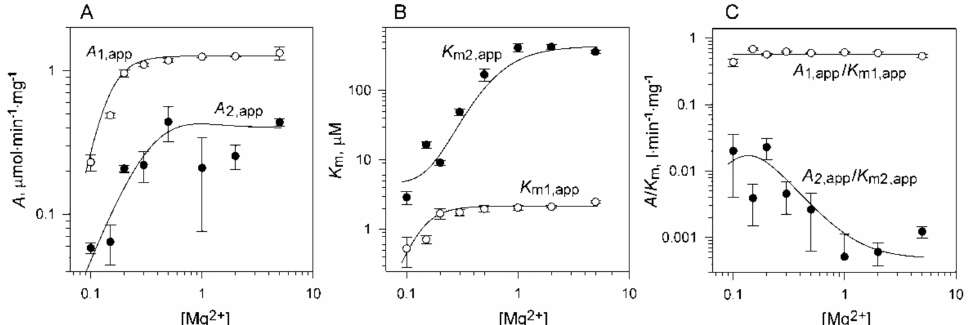
Figure 6. Secondary dependence of the kinetic parameters in Scheme 1 ( A ), maximal activities; ( B ), K m values; ( C ), their ratios) on free Mg 2+ concentration, as calculated from the data in Figure 5. All axes are scaled logarithmically. The lines were calculated using Equations (1) and (3a–d) with the parameter values found in Table